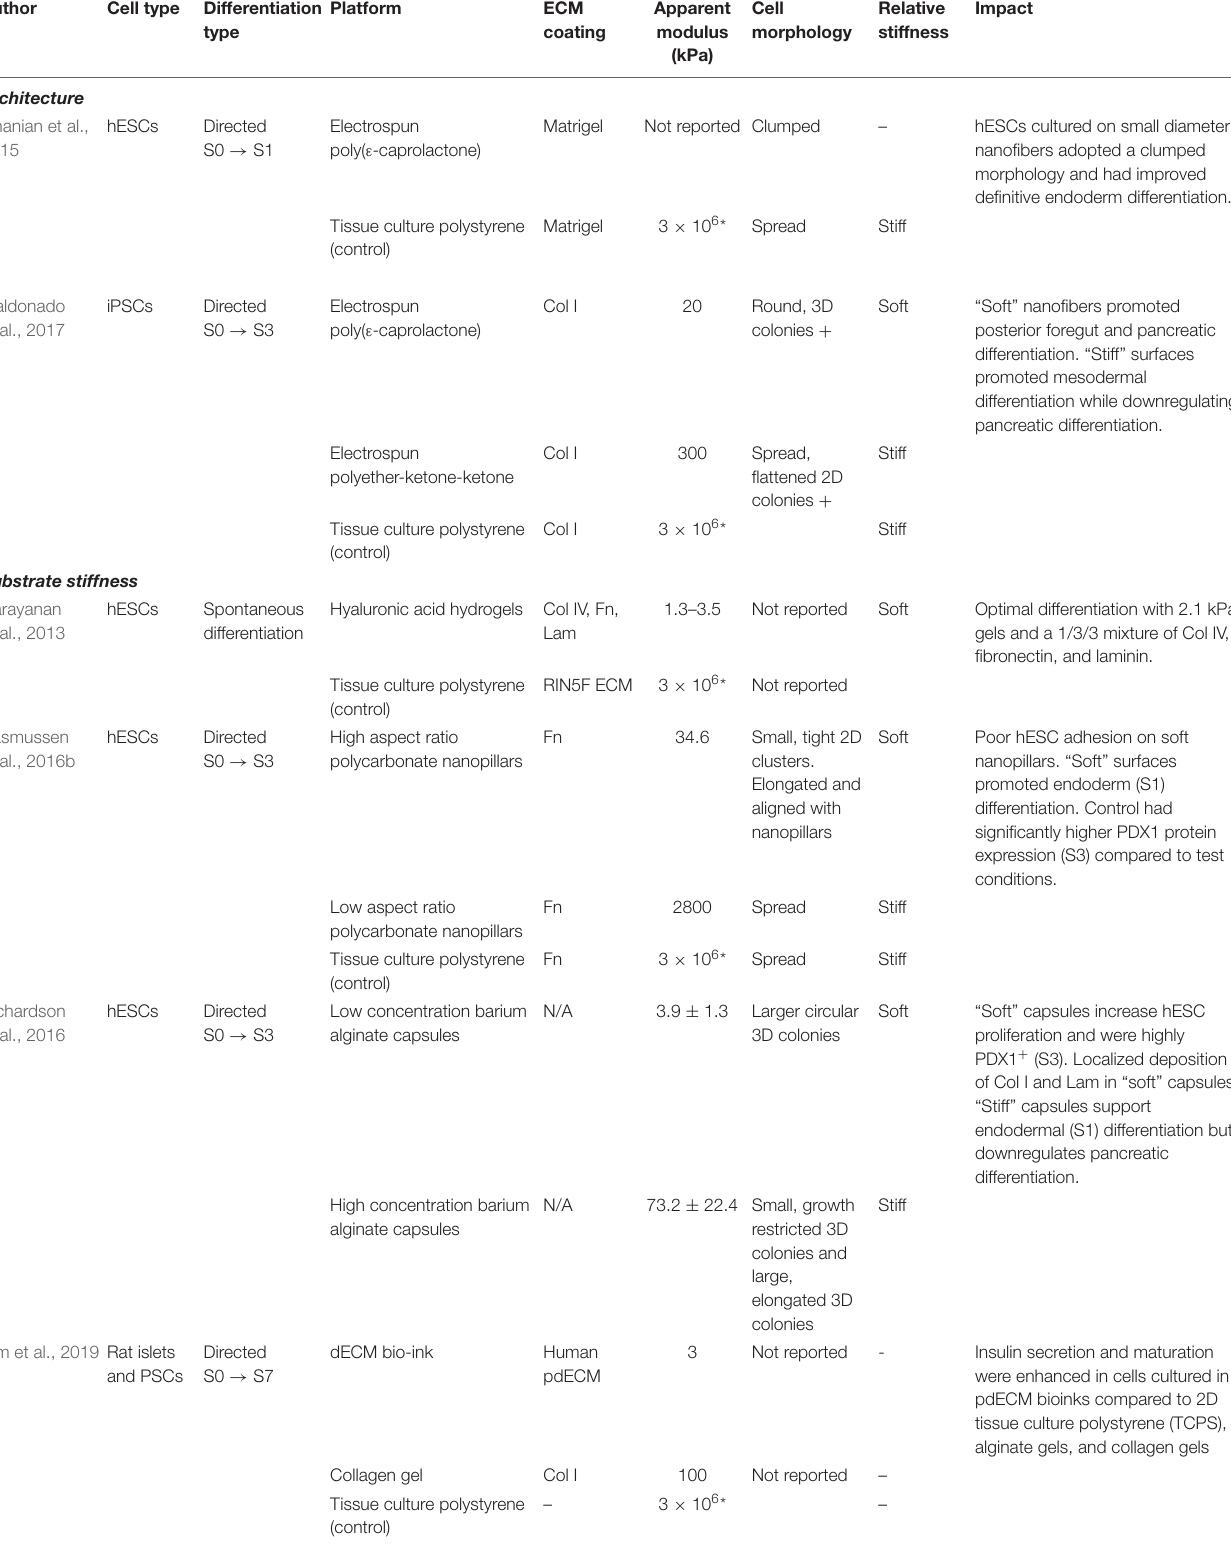
TABLE 1 | Compiled effects of substrate stiffness and architecture on various pancreatic differentiation